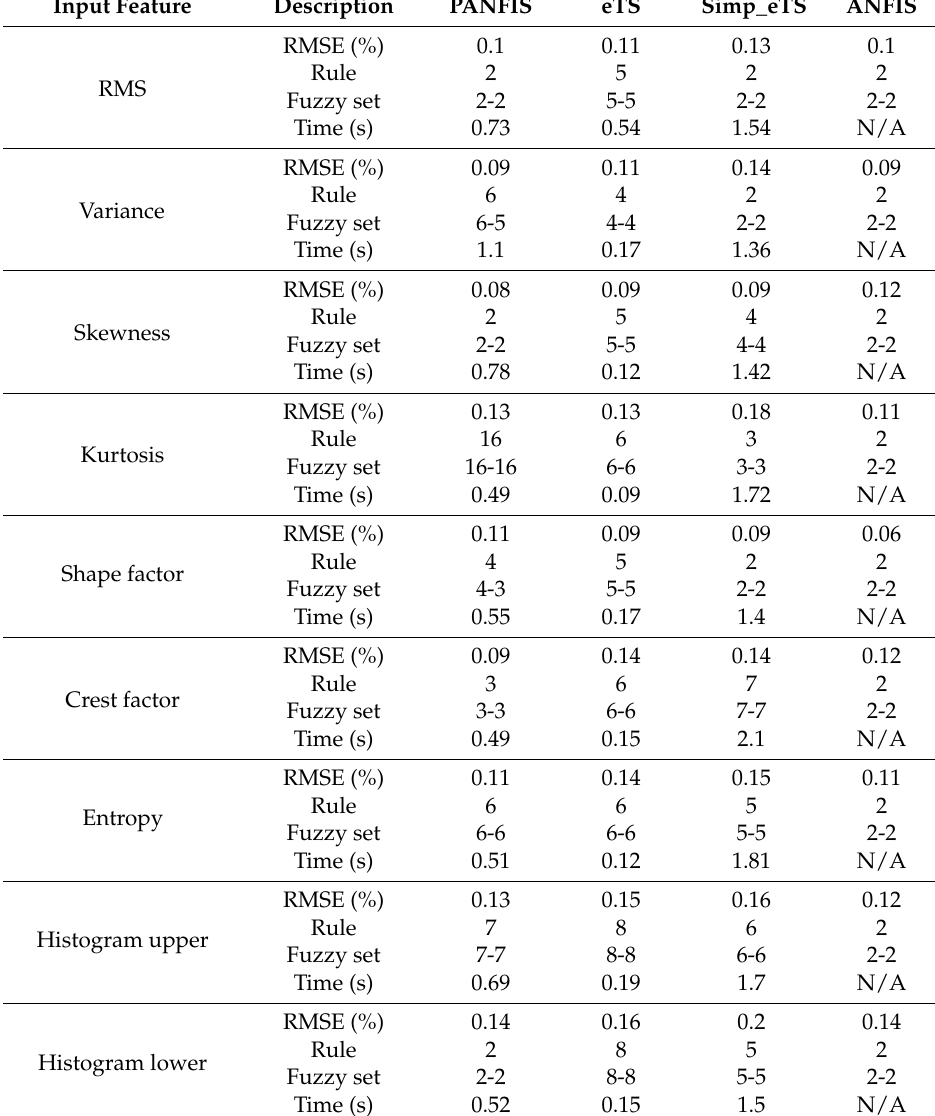
Table 3. Numerical results using time-series